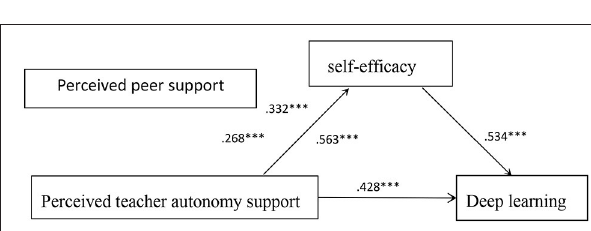
FIGURE 3 | The confirmed moderated mediation model. *** p <